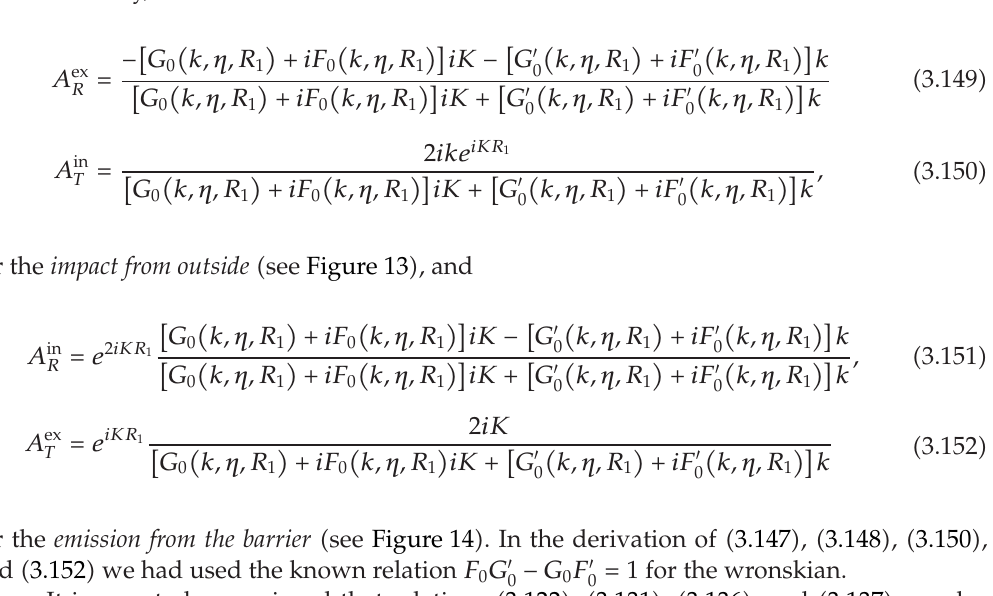
Similarly, in this case we also